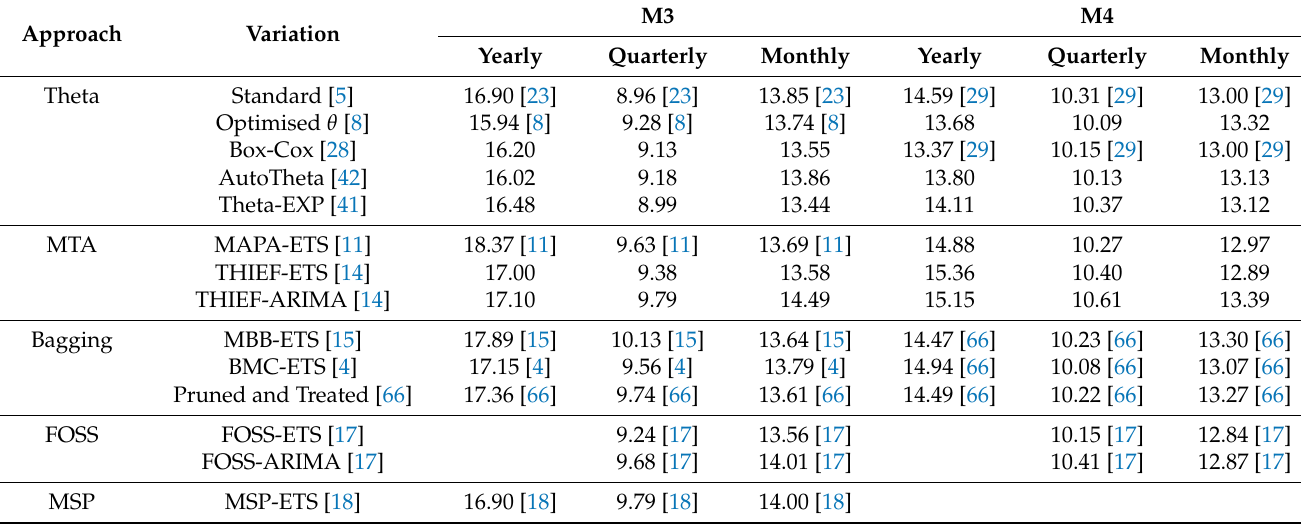
Table 3. The published average performance of the five approaches on the monthly data from the M3 and M4 competitions.